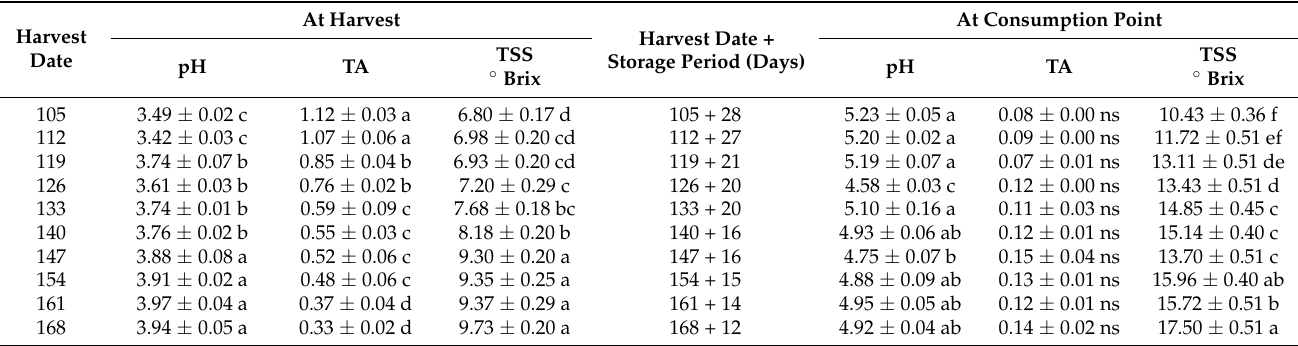
Figure 2. Number of storage days at 20 °C until fruit reaches consumption point in relation to the harvesting moment (expressed in days from full flowering). Table 5. Evolution of pH, Titratable Acidity (TA) and Total solids soluble content (TSS) at harvest (days from full bloom) and at consumption point.